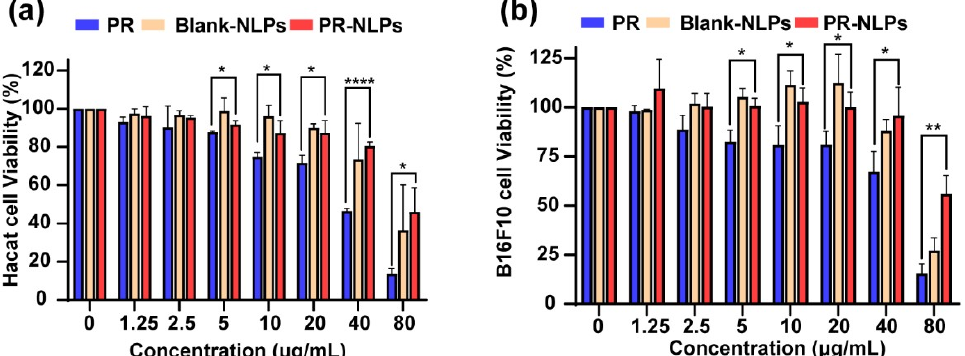
Figure 8. In vitro cellular cytotoxic activity of PR-drug, Blank-NLPs, and PR-NLPs at PR concentra- tions of 0–80 μ g/mL in ( a ) HaCaT cells. ( b ) B16F10 cells. (n = 3, * p < 0.05, ** p < 0.01, *** p < 0.001, **** p < 0001).